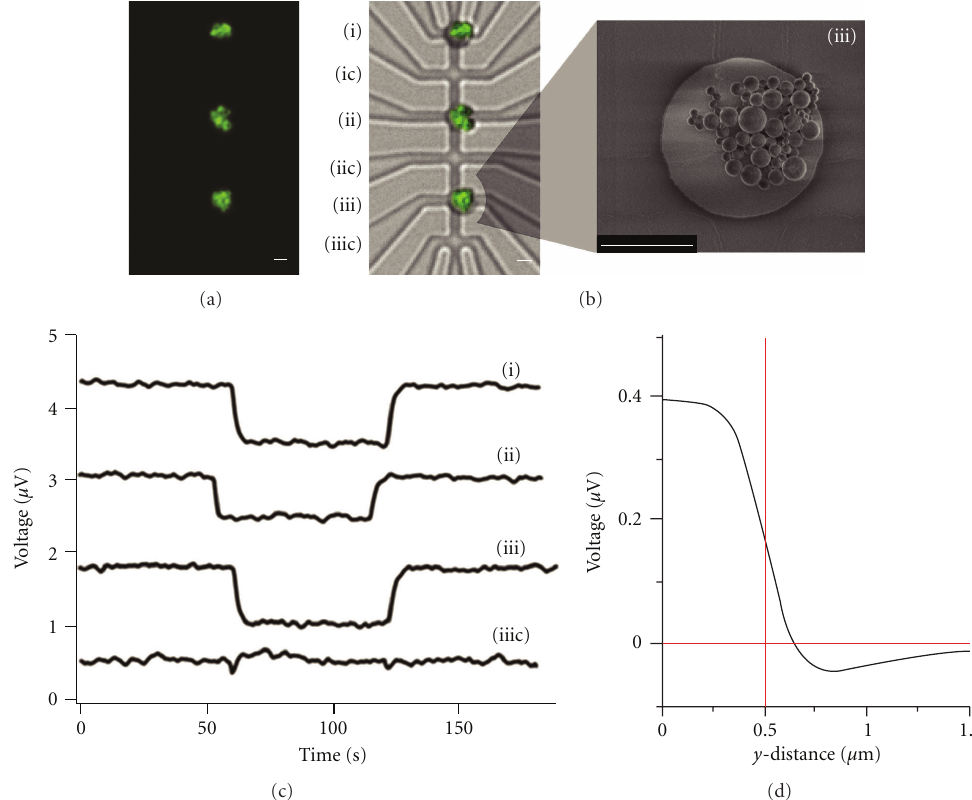
Figure 2: (a) Optical microscopy characterization (wide-field fluorescence and DIC overlay) of three-strand DNA assembly is shown by the presence of green fluorescence indicating the presence of probe DNA. (b) SEM was used to evaluate the location and to quantify the number of nanobeads contributing to the Hall response for (iii), where the grey box designates the location of the underlying Hall junction. (c) Hall responses for three active junctions (i, ii, iii) and a single control junction (iiic) are plotted as Hall voltage o ff set versus time; the presence of nanobeads over the active Hall junctions results in a drop in Hall voltage when a dc magnetic field is applied. (d) The theoretical device signal stemming from a single 344 nm SPM bead is shown to the right as a function of position over the Hall junction further illustrating the local sensitivity of Hall magnetometry. Scale bars = 2 µ m in (a) and